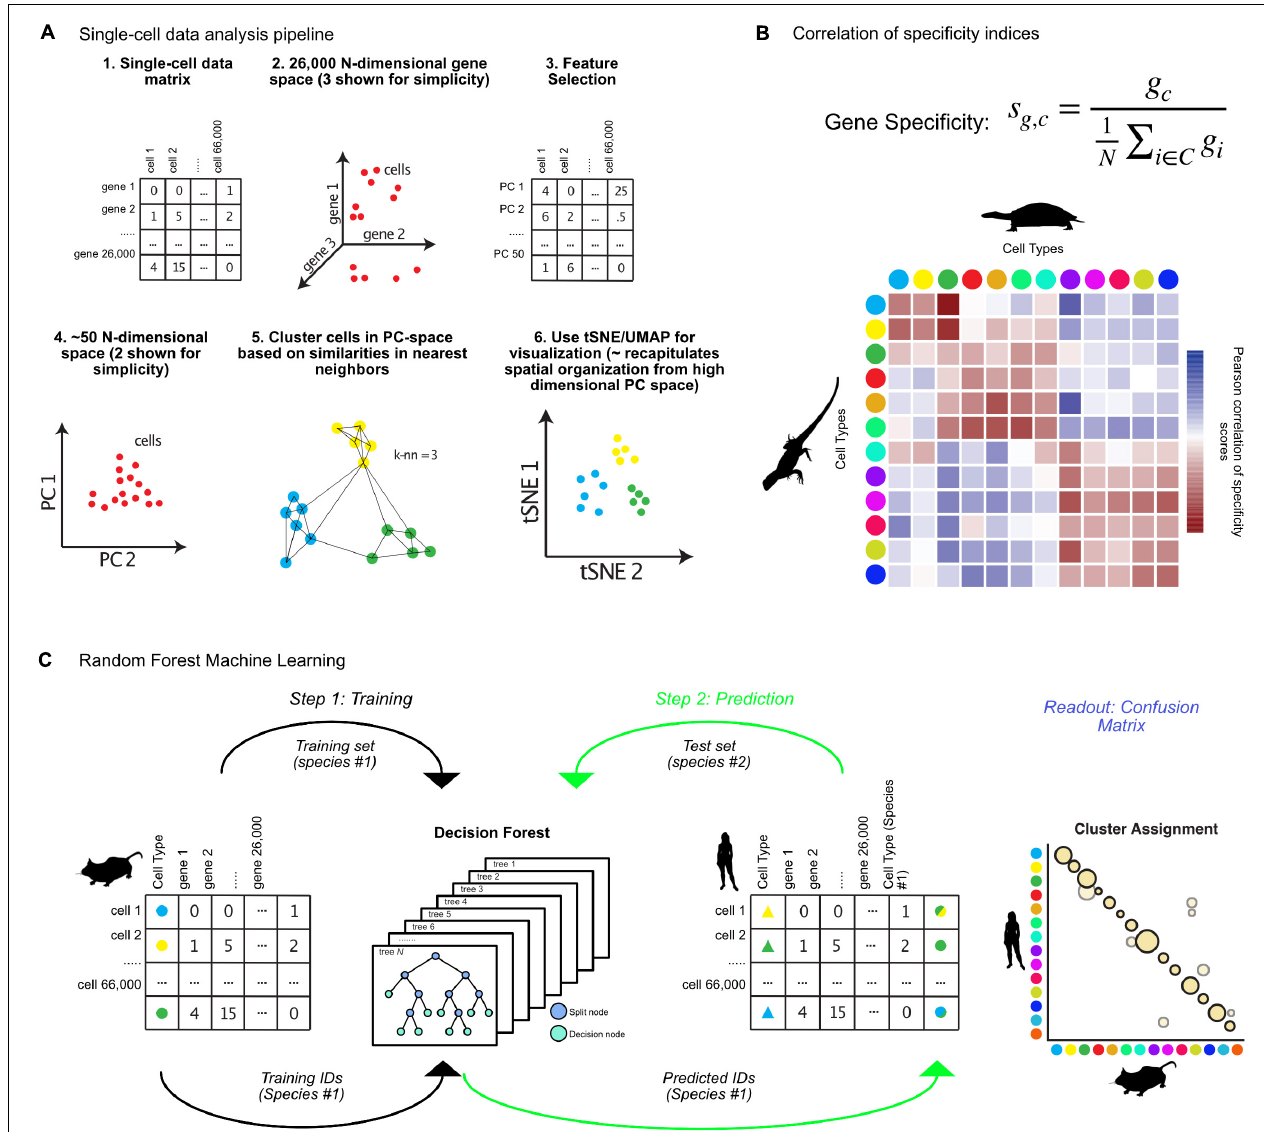
FIGURE 1 | Matching cell clusters in single-cell RNA-seq across species. (A) Overview of bioinformatic pipeline for single-cell sequencing analysis from the R toolkit Seurat , including feature selection, dimensionality reduction, and graph-based clustering. Seurat takes a cell by gene expression matrix (steps 1, 2), and first identifies features (genes) for dimensionality reduction (steps 3, 4). Using principal components, Seurat identifies clusters using graph-based methods, then visualizes resulting clusters using tSNE or UMAP (steps 5, 6). (B) Equation for calculation of gene specificity, and example correlation of these values between turtle and lizard cell types (colored dots) where Pearson correlation coefficient values in red indicate positive correlation and blue indicate negative correlation. (C) Random forest machine learning algorithms for identifying cross-species cell type annotations involves first training an algorithm on cell types from one species (step 1), then predicting which of those cell types each cell from a different species most resembles (step 2), which results in a confusion matrix (Readout). Animal silhouettes were obtained from PhyloPic (www.phylopic.org). All silhouettes were used under the Public Domain Dedication 1.0 license, except the image of a turtle, which is attributed to Scott